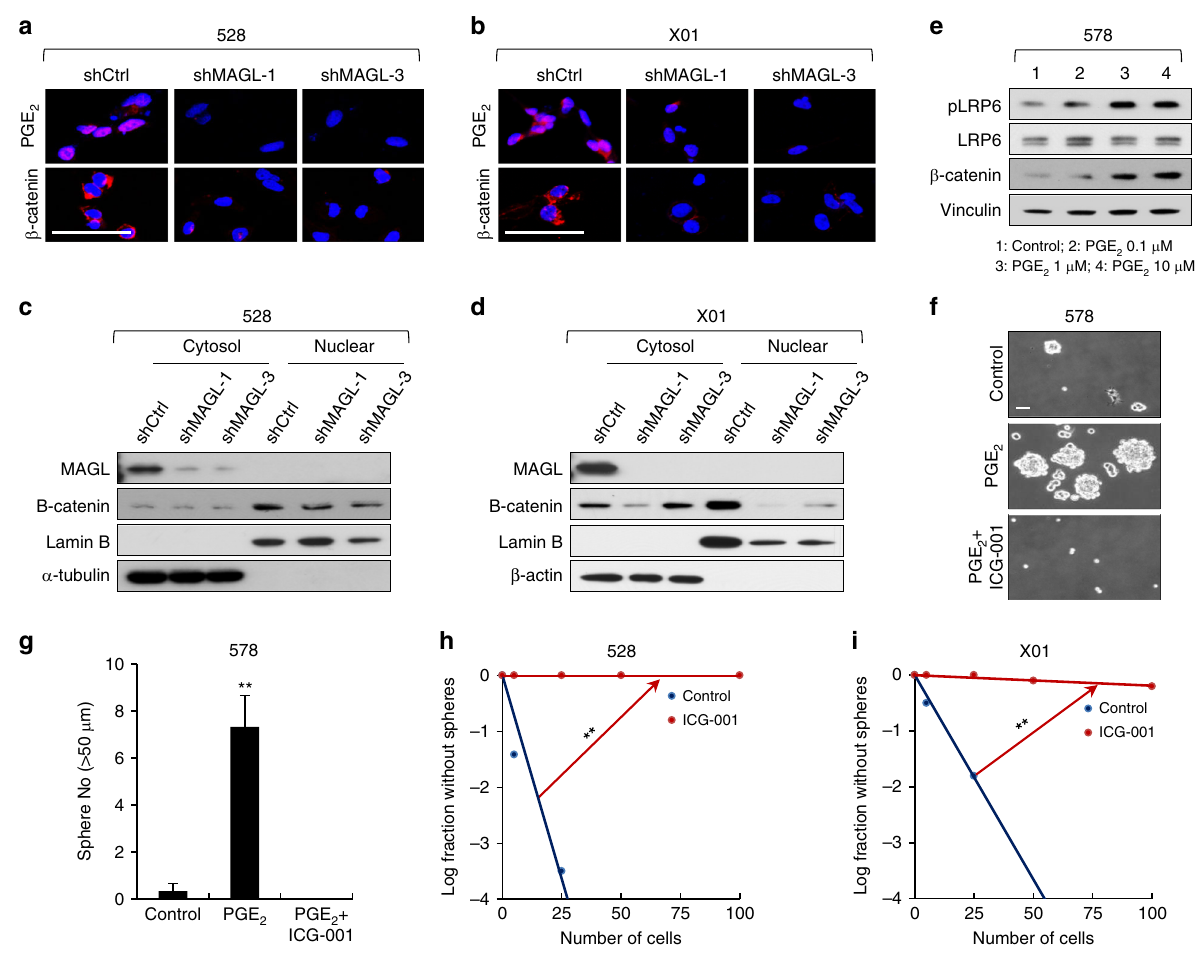
Fig. 5 MAGL modulates GSC self-renewal by regulating PGE 2 . a , b Representative ICC images of PGE 2 and β -catenin in GSCs (528 and X01 cells) infected with a shMAGL-expressing lentiviral or shCtrl construct. Scale bar, 50 µ m. c , d Immunoblot (IB) analysis of MAGL and β -catenin in fractionated nuclear or cytosolic lysates from 528 cells and X01 cells infected with a shMAGL-expressing lentiviral or shCtrl construct. Lamin B and β -actin were used as markers for nucleus and cytoplasm, respectively. e IB analysis of β -catenin in 578 cells treated with different concentrations of PGE 2 (0.1, 1, and 10 μ M). Vinculin was used as a loading control. f , g Sphere-formation assays performed using GSCs (578 cells) treated with PGE 2 alone, PGE 2 and ICG-001 (10 μ M), or vehicle. Images are representative of three independent experiments. Scale bar, 50 µ m. The graph shows the average number of spheres >20 μ m in diameter. All error bars represent mean ± SEM ( n = 3). ** P < 0.01, t -test. h , i Limiting dilution assays (LDAs) performed using GSCs (528 and X01 cells) treated with ICG-001 (10 μ M) or vehicle. ( n = 24, ** P < 0.01, t M2 macrophages by treating with lipopolysaccharide (LPS) or interleukin (IL) − 4, respectively, or with PGE 2 . Treatment with PGE 2 induced expression of the M2-like macrophage markers, CD206 (MRC1), CD163, and ARG1 (arginase-1), to an extent comparable to that induced by IL4 (Fig. 6a, b and Supplementary Fig. 6c – e) 35,36 . Expression of Krupple-like factor 4 (KLF4), a key transcription factor that regulates expression of M2-like TAM genes 31 , was signi fi cantly increased by IL4 or PGE 2 treatment (Fig. 6a and Supplementary Fig. 6c). In contrast, treatment of macrophages with PGE 2 reduced the expression of tumor necrosis factor (TNF)- α and CD86, markers of M1-like macrophages (Fig. 6a, c and Supplementary Fig. 6c, e, f) 31,35 . To further demonstrate PGE 2 -induced M2-like TAM polarization, we sorted CD11b and F4/80 double positive TAMs from mouse xenograft model, regarded as more relevant to real TAMs, extracted from ARS2-knockdowned orthotopic xenograft mouse, and further con fi rmed the effect of PGE 2 on inducing M2-like polarization in the sorted TAMs. PGE 2 treatment on the FACS-sorted TAM from shARS2 and shMAGL tumors increased M2-like TAM marker CD206 expression, which supported our theory of ARS2/MAGL